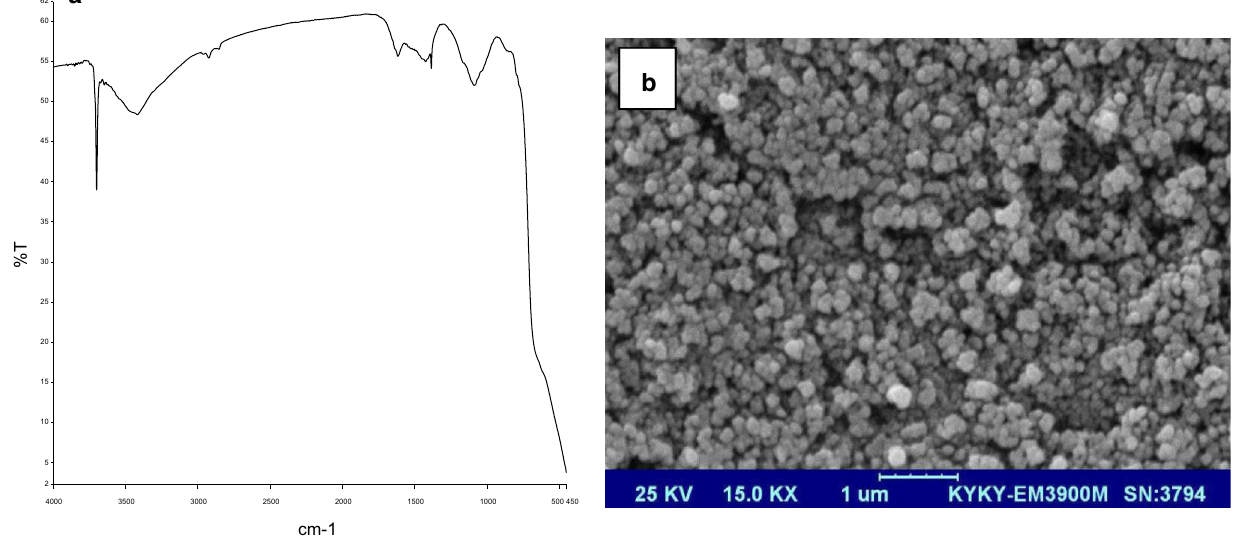
Fig. 2 a FTIR pattern and b SEM image of the MgO nanoparticles